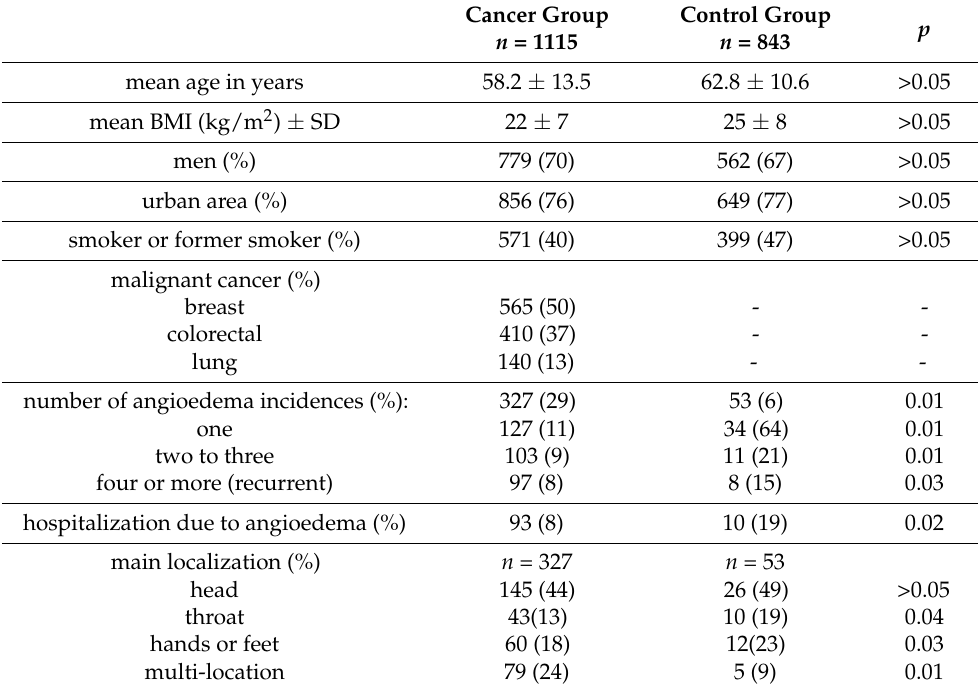
Table 1. Characteristics of the study and control